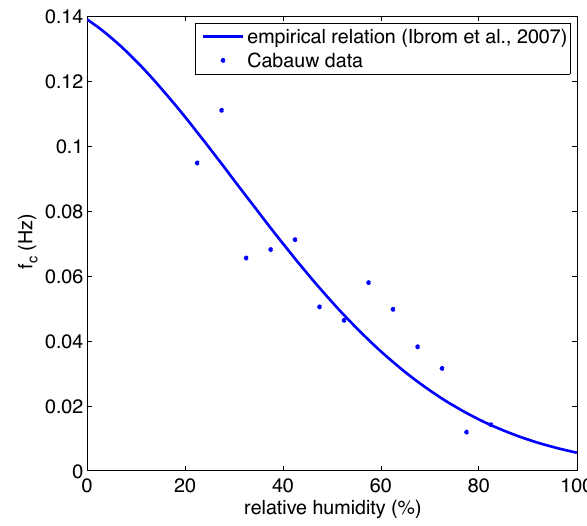
Fig. A1. Cut-off frequency for water vapor as a function of relative humidity. The symbols are the results from combining different fits to the spectra and various data selection criteria applied to the Cabauw data. The solid line represents the empirical model pre- sented by Ibrom et al.